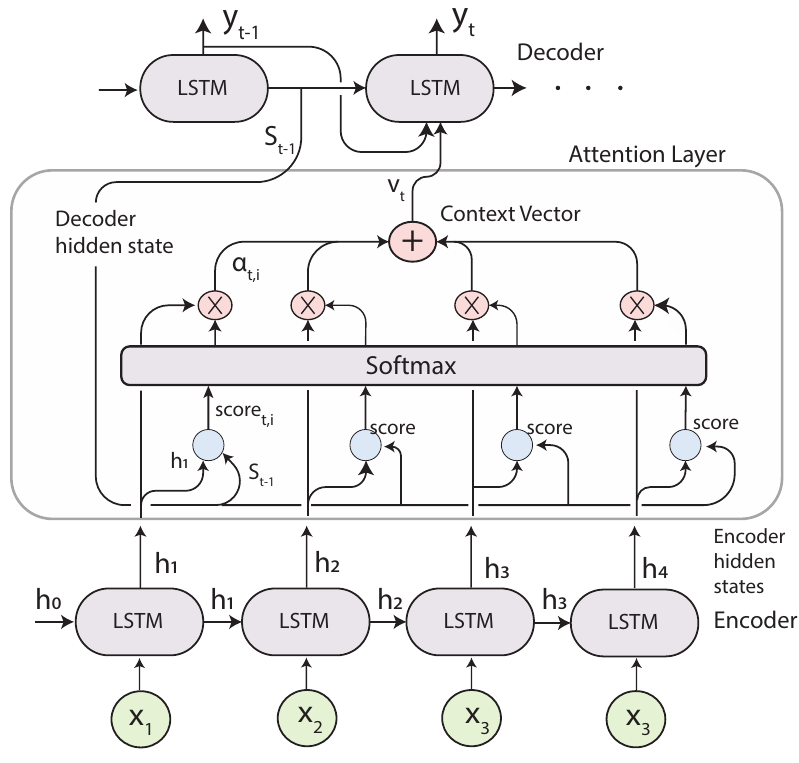
Figure 9. Sequence to Sequence with the Attention mechanism adapted from [9].